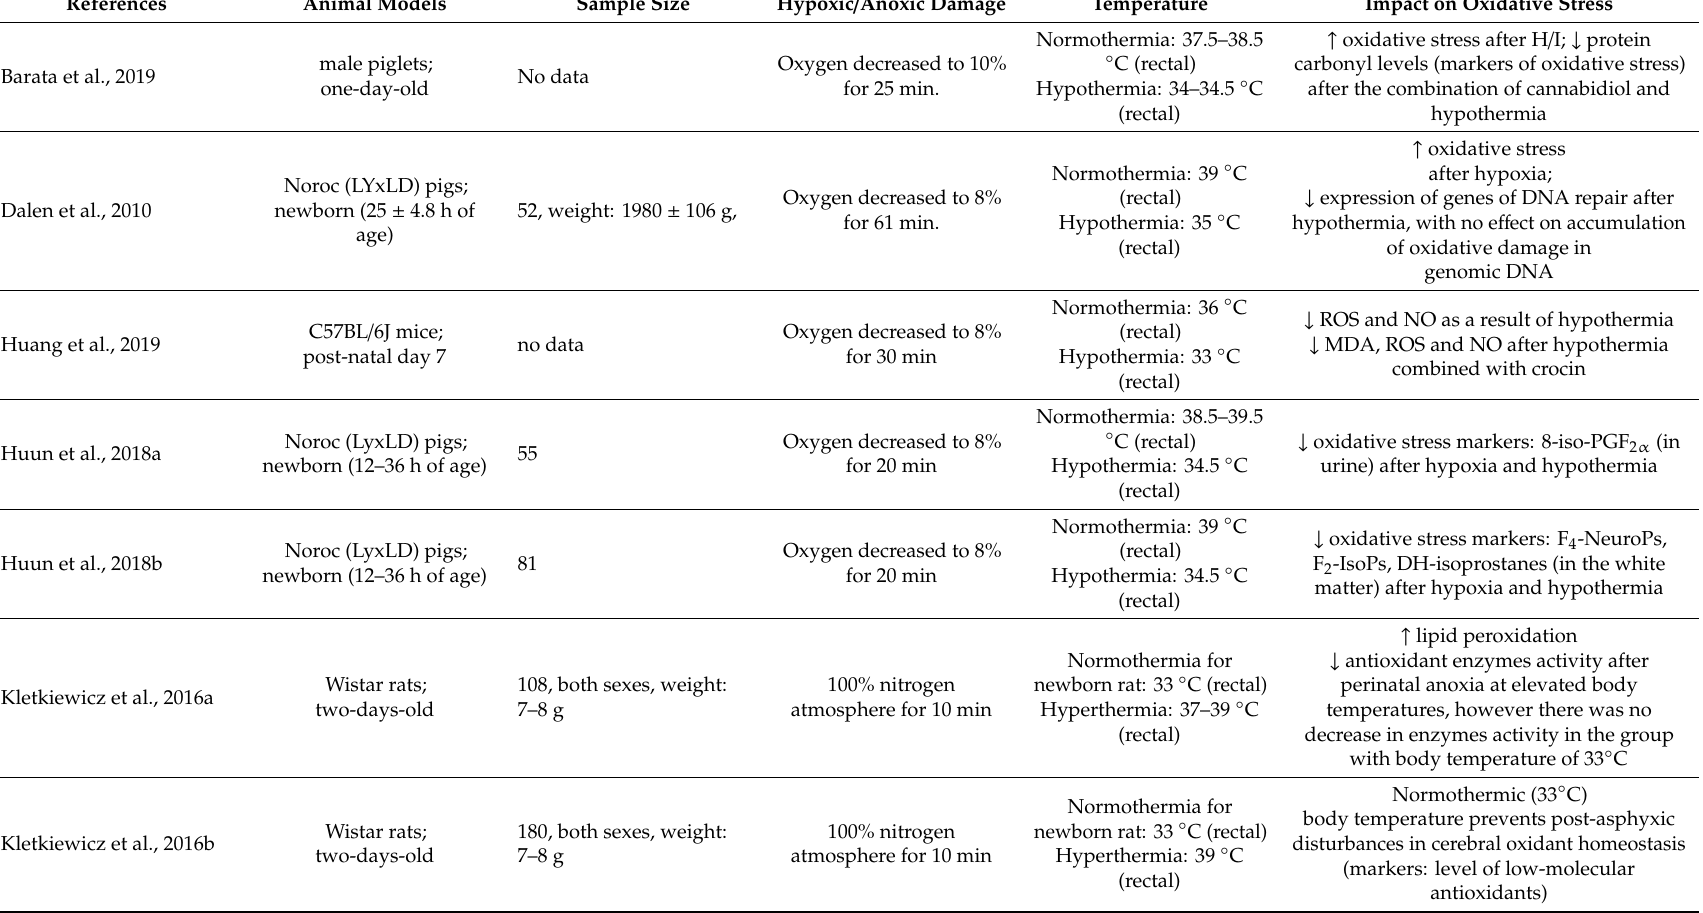
Table 1. E ff ects of therapeutic hypothermia on oxidative